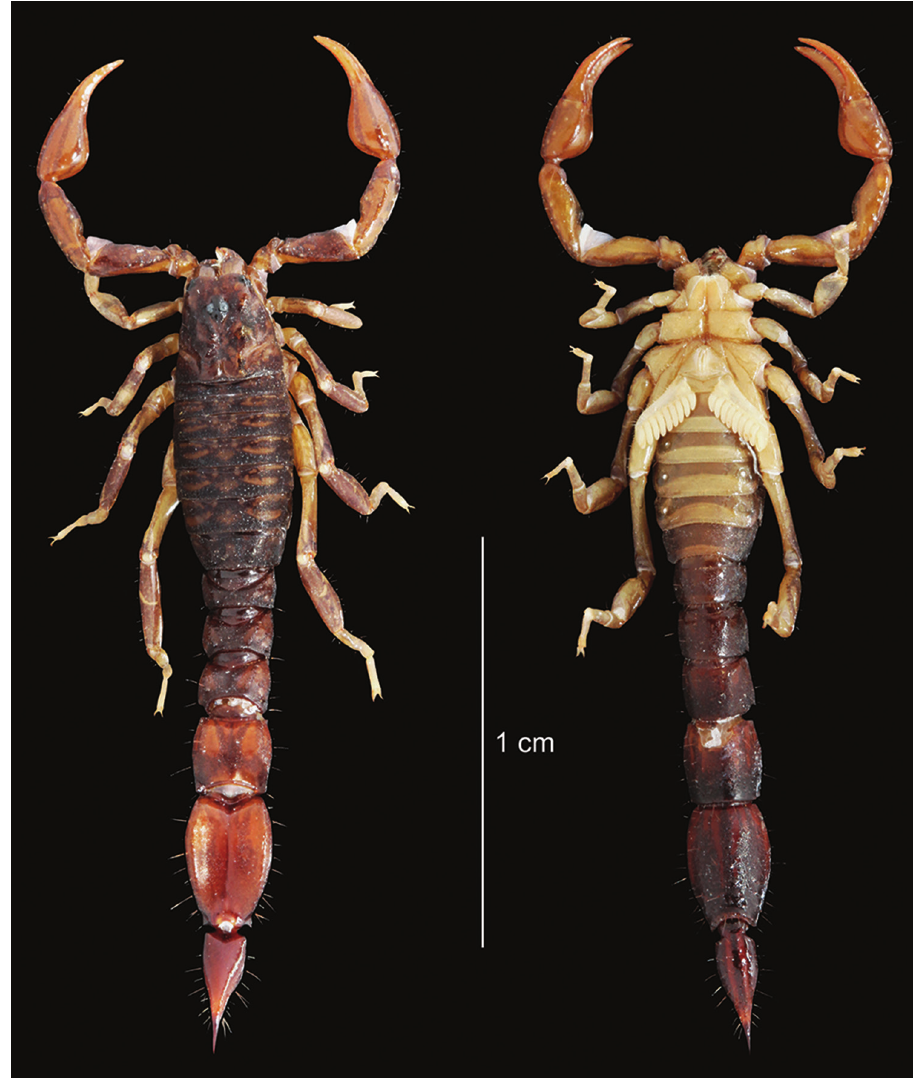
Figure 27. Hadrurochactas cristinae sp. n., male holotype from Roura. Habitus, dorsal and ventral aspect. Diagnosis. Total length 18.9 mm for male holotype (see morphometric values after the description). Coloration yellowish brown, densely spotted on the carapace, the tergites and the appendages. Mesosoma yellowish, densely spotted with confluent brown to dark brown spots, without yellowish longitudinal median stripe. Chelicerae yellowish with variegated brownish spots over the entire surface. Legs tarsal segments yellowish with diffused brownish pigmentation. Pectines with 9–9 teeth on male holo- type; female unknown. Trichobothrial pattern of type C, neobothriotaxic (majorante) ‘major